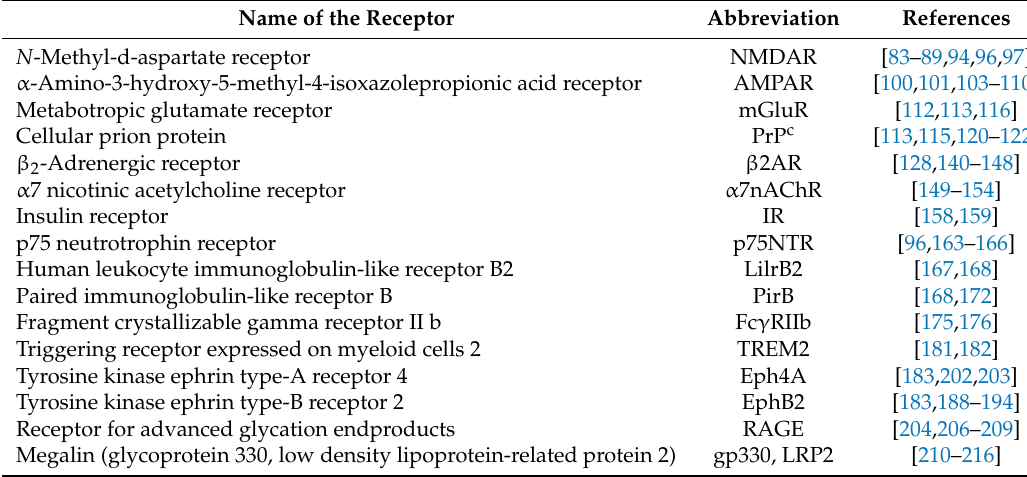
Table 1. Cellular receptors related to amyloid β oligomer (A β O)